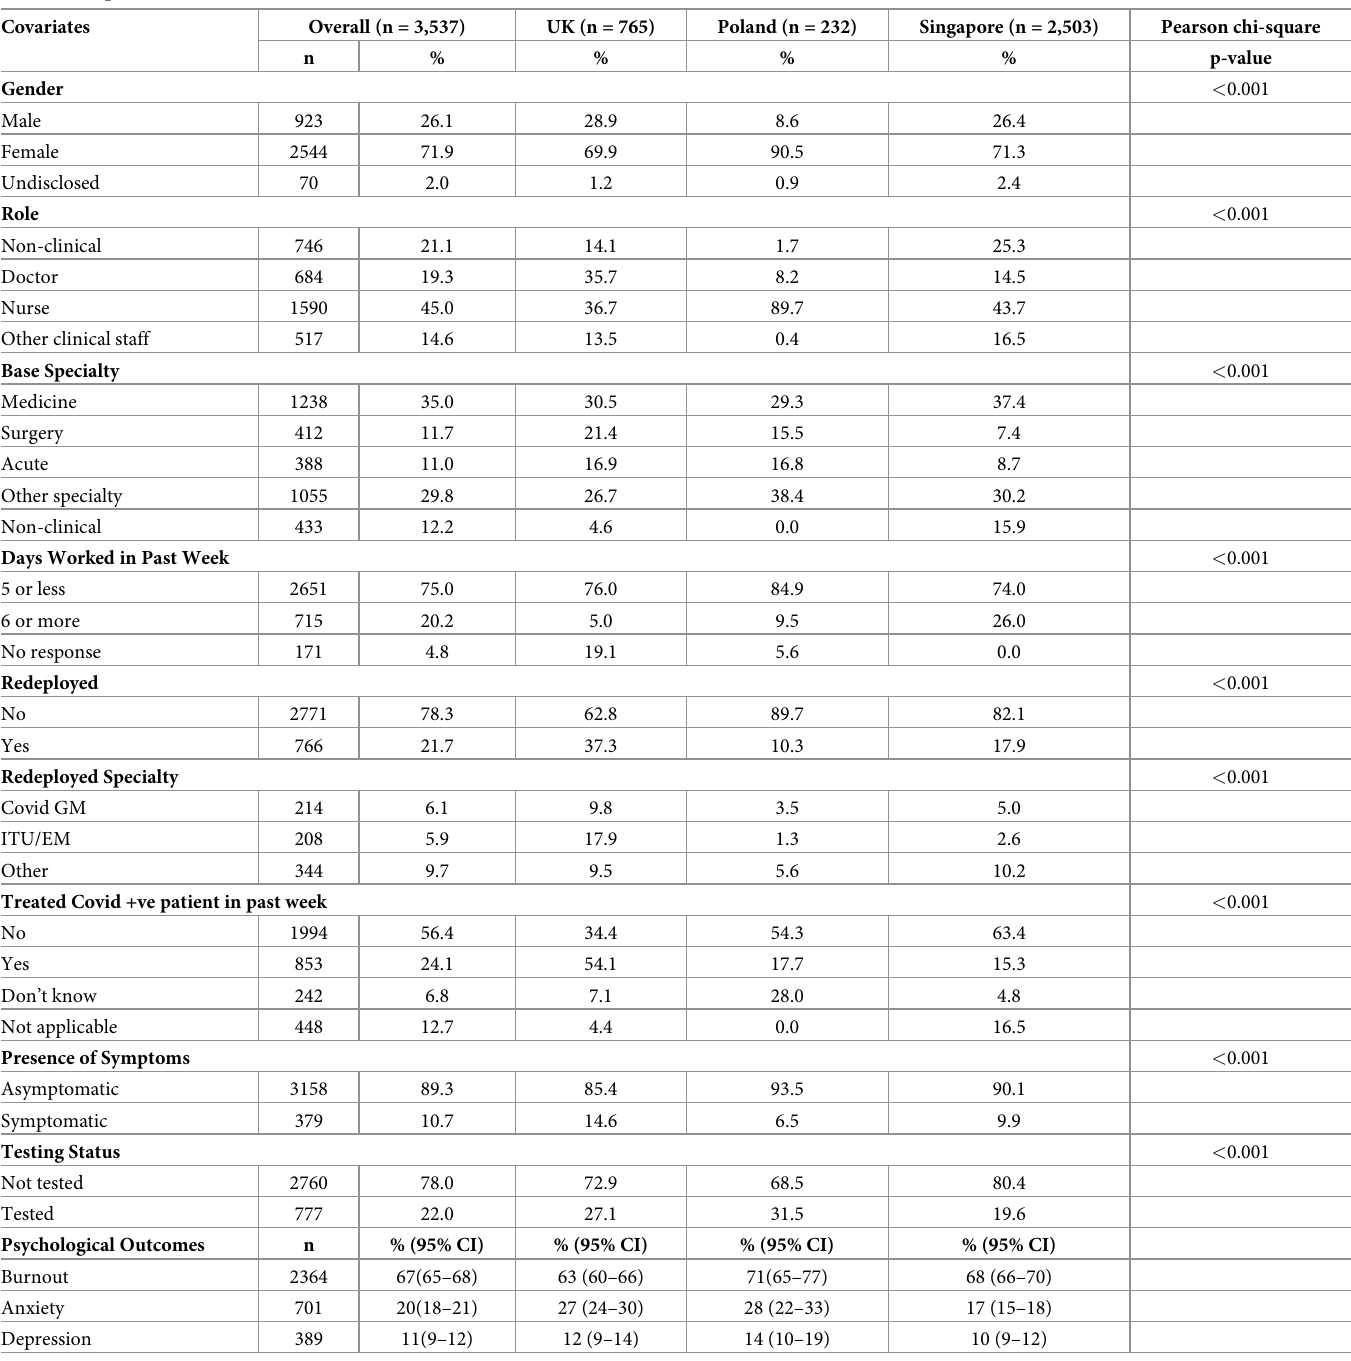
Table 2. Respondent